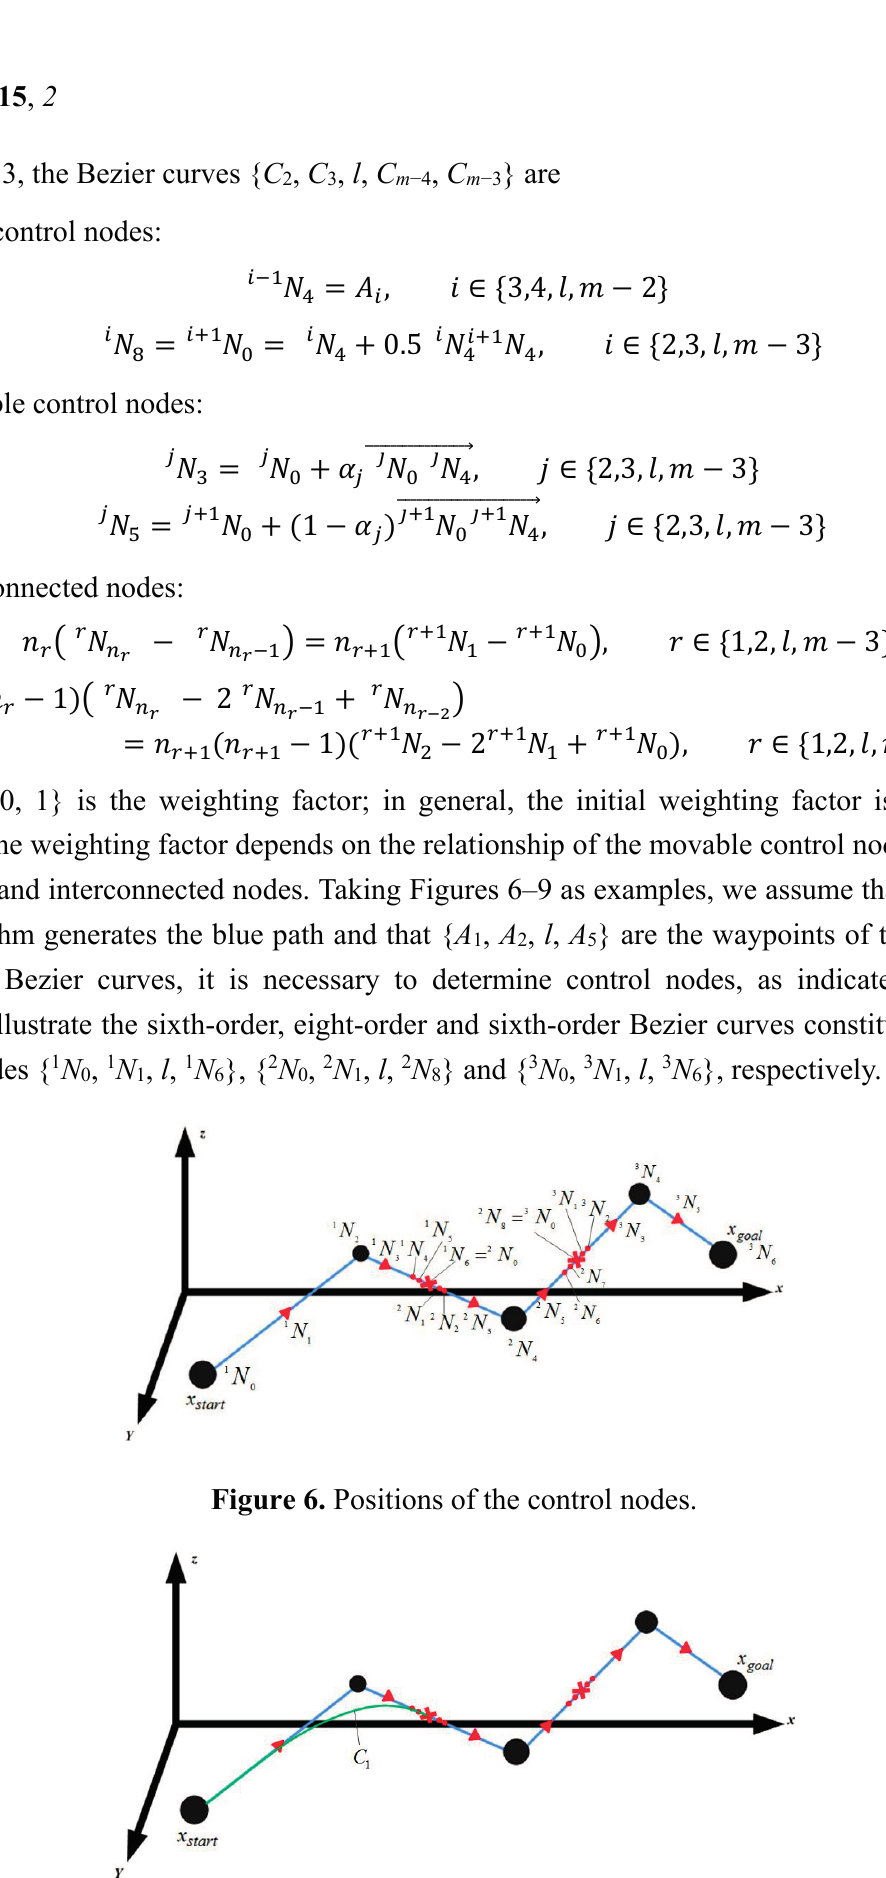
Figure 7. Result of the sixth-order Bezier curve C 1 constituted by the nodes { 1 N 0 , 1 N 1 , l , 1 N 6